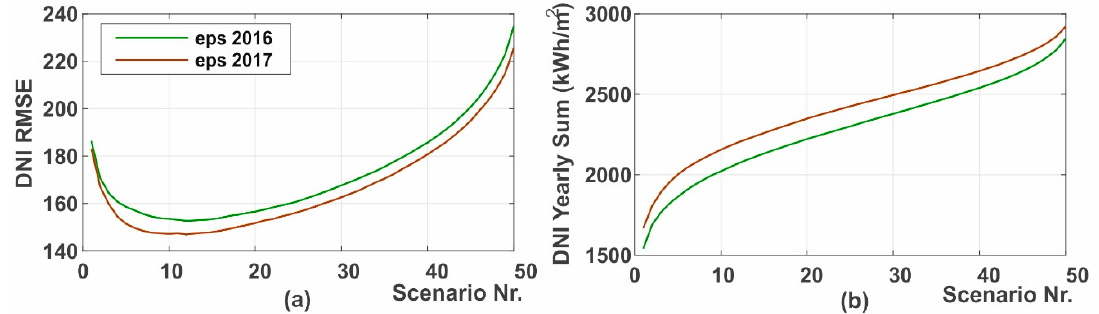
Figure 11. Root mean square error ( a ) and yearly sum of the direct normal irradiation ( b ) of each scenario from the probabilistic sets. Scenarios are sorted from minimum to maximum DNI values.